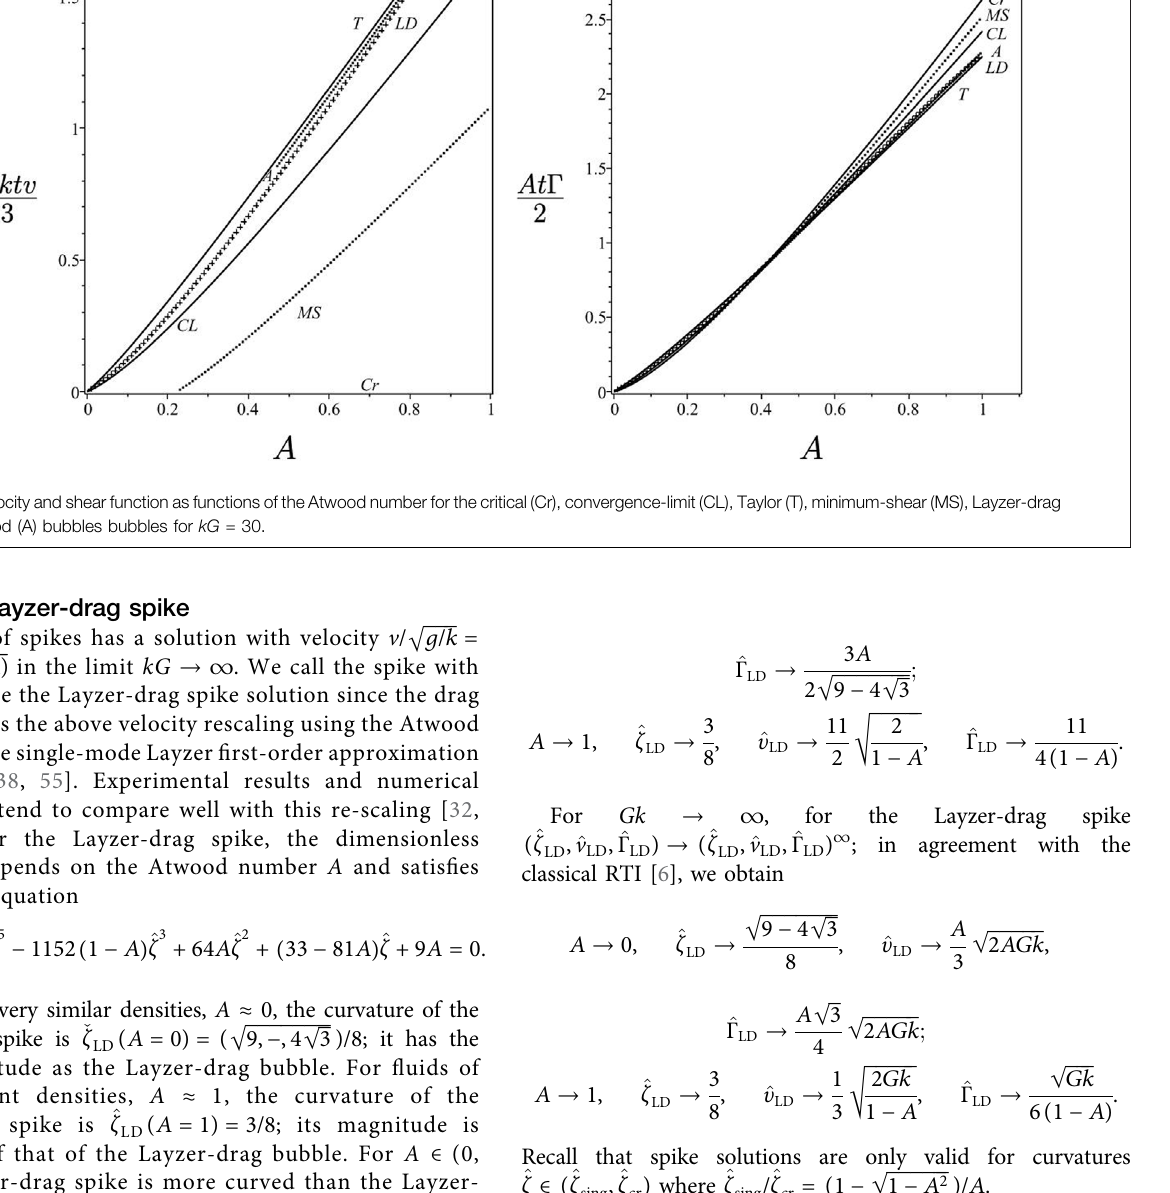
Figure 9 consists of plots of the velocity and shear function of the Layzer-drag spike as functions of the acceleration parameter kG . ^ ζ (cid:1) ζ Figure 10 is a plot of the scaled curvature / k as a function of the Atwood number A for the critical, convergence limit, Taylor and Layzer-drag spikes. Figure 11 illustrates the plots of their corresponding velocities and shear functions.